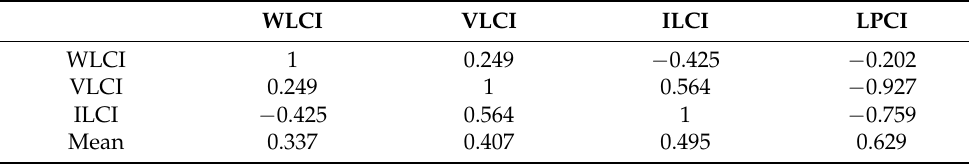
Table 7. Correlation matrix of LPCI and three comprehensive